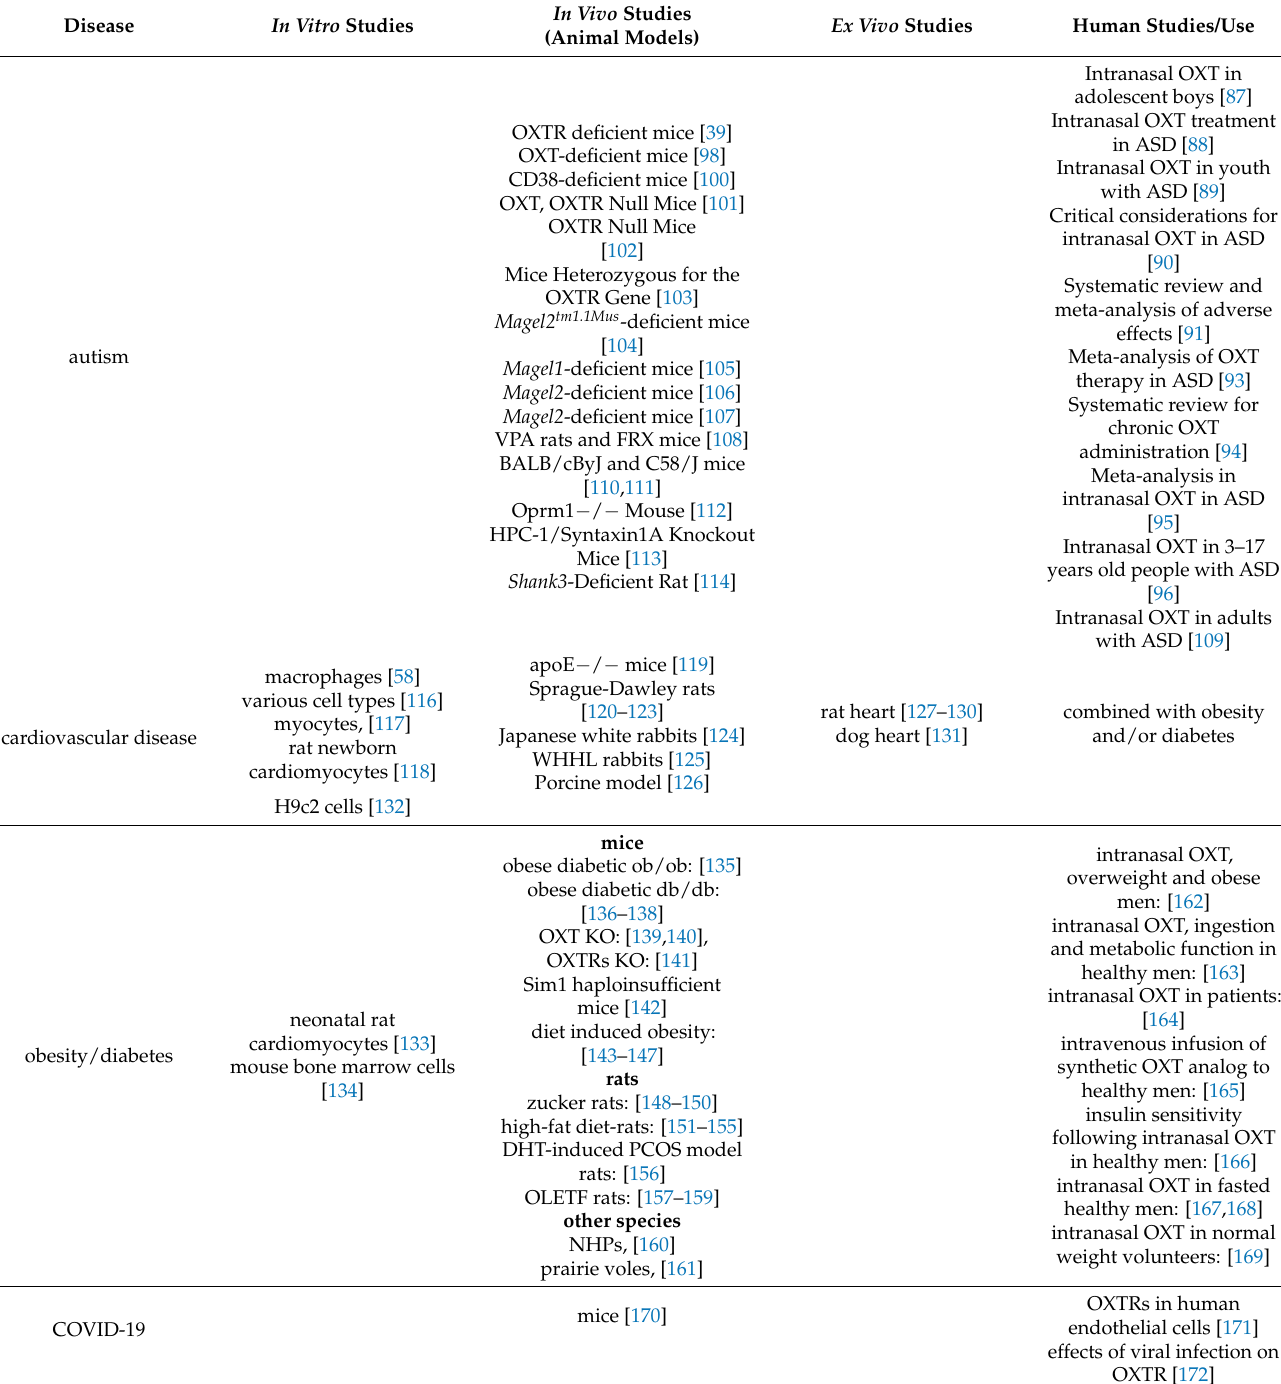
Table 1. Studies ( in vitro , in vivo , ex vivo and human) related to the use of oxytocin for the medication of degenerative diseases